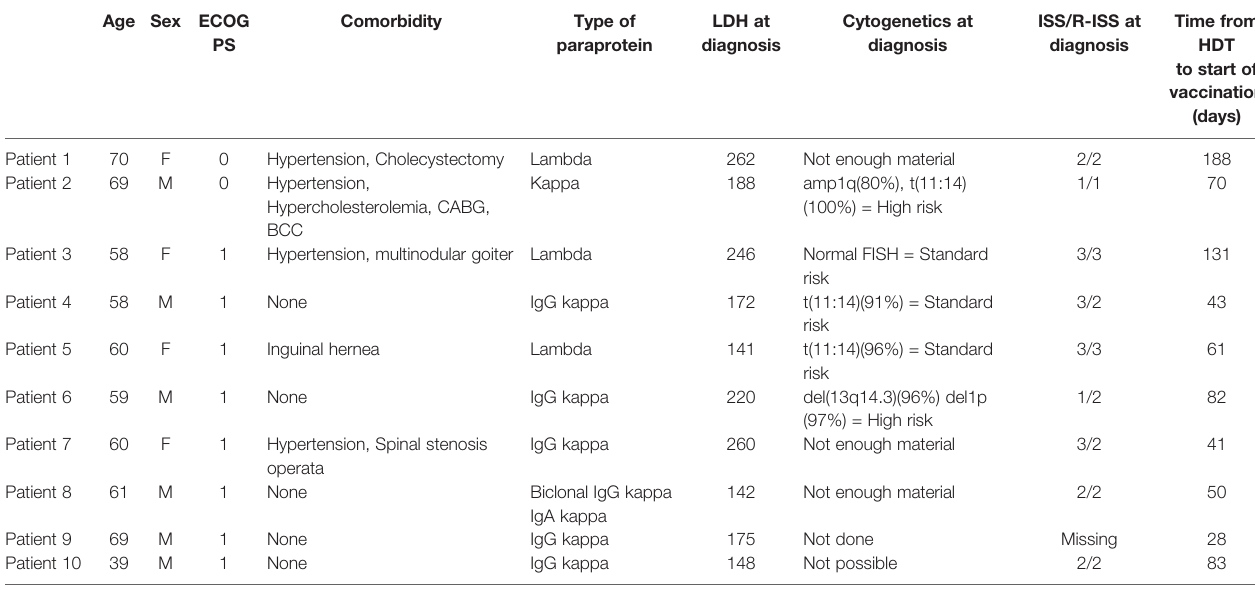
TABLE 1 | Patient